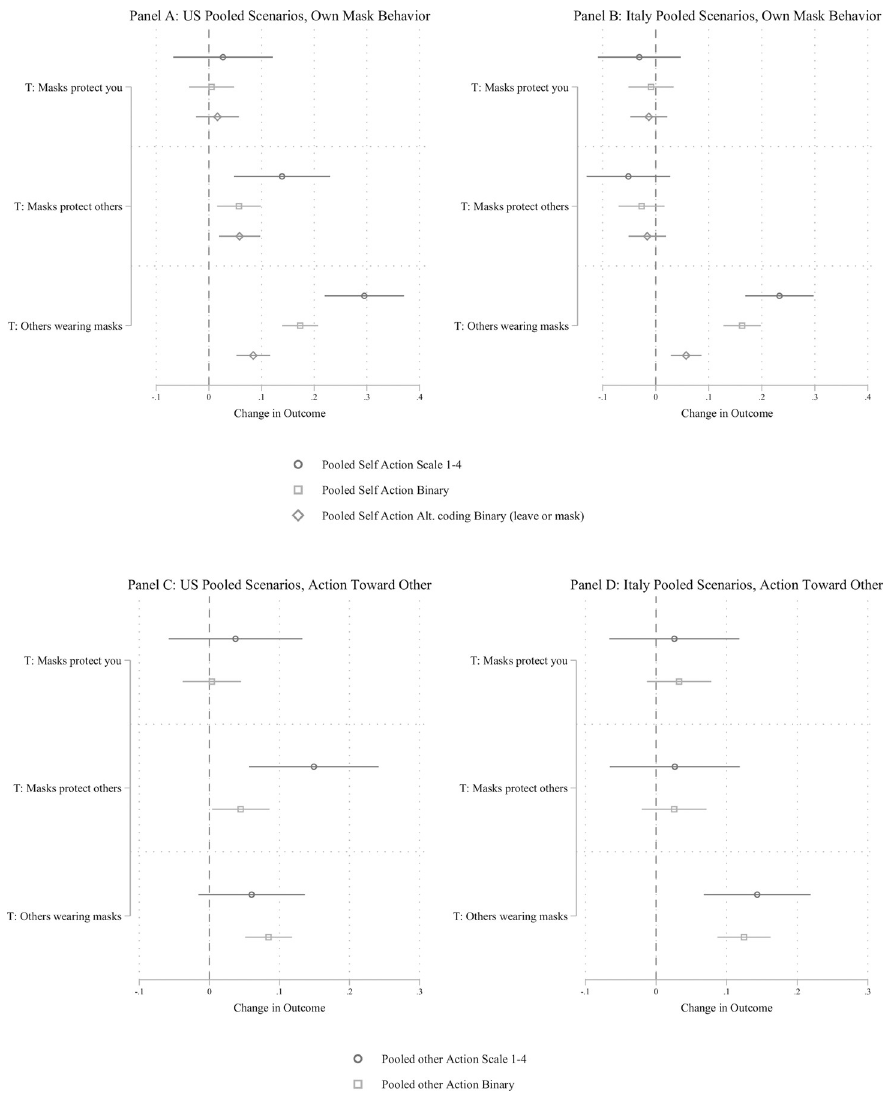
Fig 2. Effect of beliefs and prevalence of mask wearing on behavioral intentions. Panels A and B show the effect of the mask efficacy treatments and social norms treatment for the OWN mask behavior outcomes for the US and Italy respectively. Panels C and D show the same treatment effects for the OTHERS outcomes. The figure displays OLS regression estimates with 95% confidence intervals. Models include covariates described in S3 Appendix. For the United States, we observe a positive and statistically significant effect of the Masks Protect Others treatment on the OWN and OTHERS outcomes. For the others wearing masks treatment, participants in both the United States and Italy were more likely to report that they would retrieve their mask or ask someone else to fix their mask when most or all of the other people described in the vignette were wearing their mask.